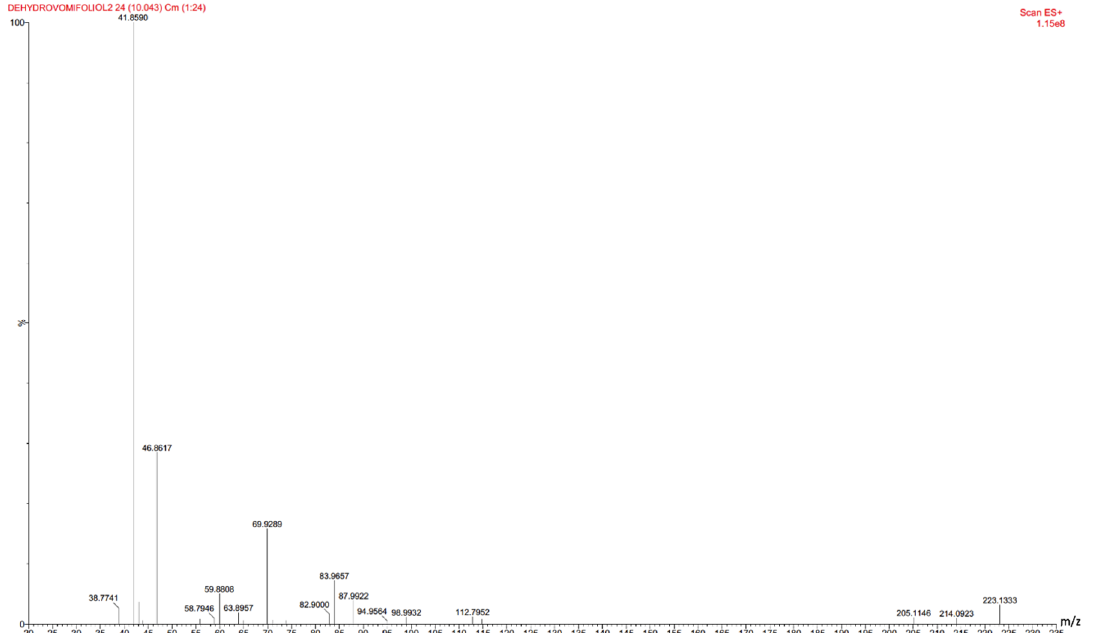
Figure 3. Mass spectrum of metabolite I obtained in the positive electrospray ionization mode. ESI–TOF MS m/z (relative intensity): 223.1333 (C 13 H 18 O 3 , calcd 223.1334) [M + H] + (3), 205.1225 (C 13 H 17 O 2 , calcd 205.1229) [M + H-H 2 O] + (1), 87.9922 (C 3 H 4 O 3 , calcd 88.0160) (4), 69.9989 (C 3 H 2 O 2 , calcd 70.0055) (16), 46.8617 (CH 3 O 2 , calcd 47.0133) (28), 41.8590 (C 2 H 2 O, calcd 42.0106) (100).